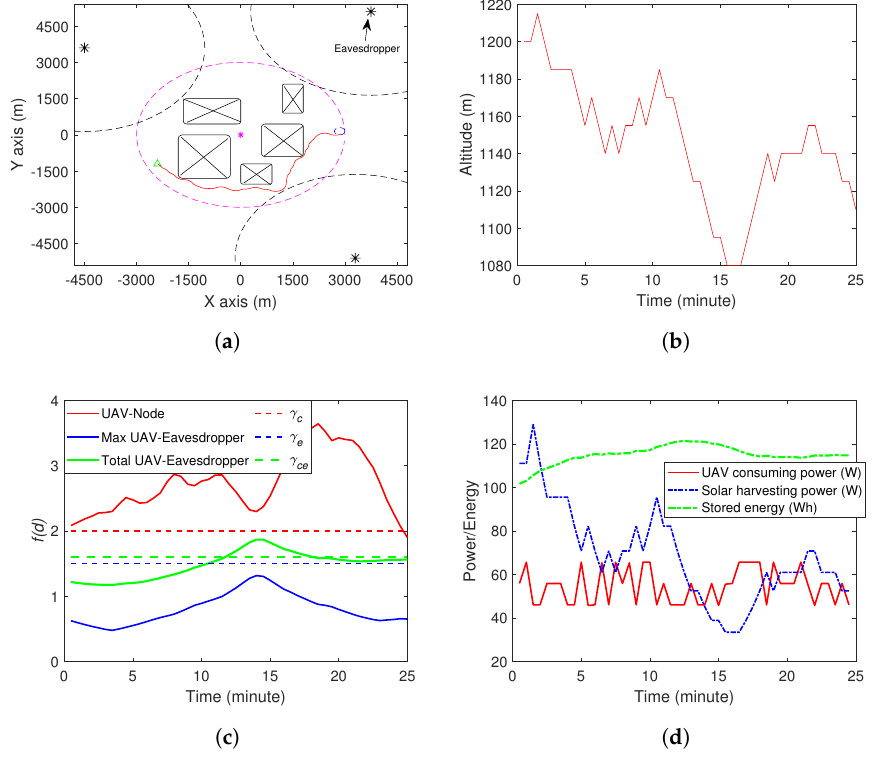
Figure 4. Simulation results in Environment 2 by the benchmark method. ( a ) The UAV movement on x-y plane. A video is available: https://youtu.be/FzNNrJzABzQ. ( b ) The UAV altitude. ( c ) The communication and eavesdropping performance. ( d ) Energy consumption and solar energy